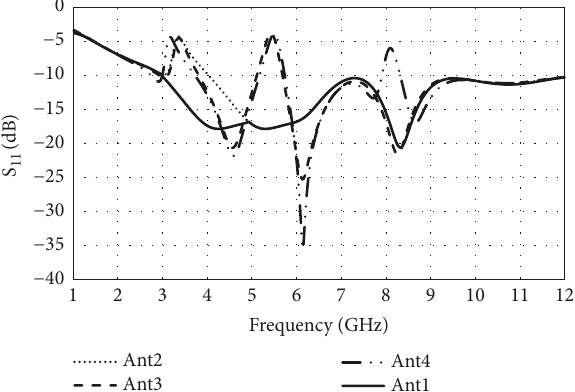
Figure 2: Comparison of simulated VSWR of the proposed UWB antenna. Figure 3: Comparison of simulated S 11 of the proposed UWB